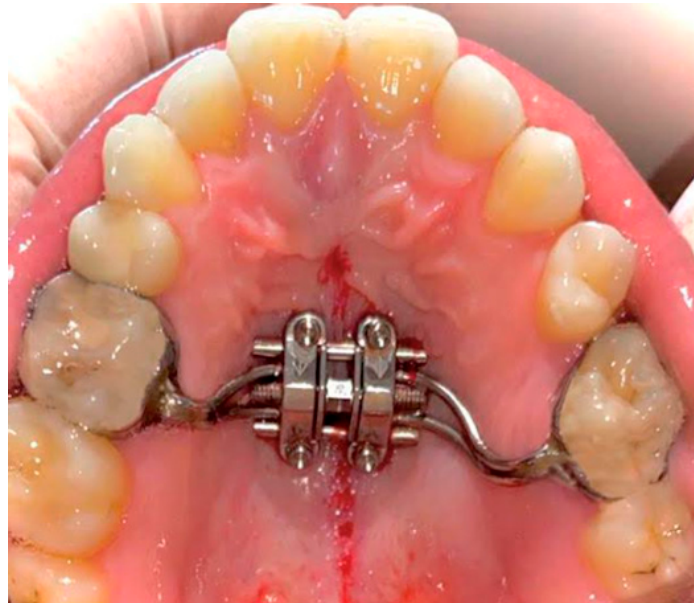
Figure 3. MARPE device in position after cementation.